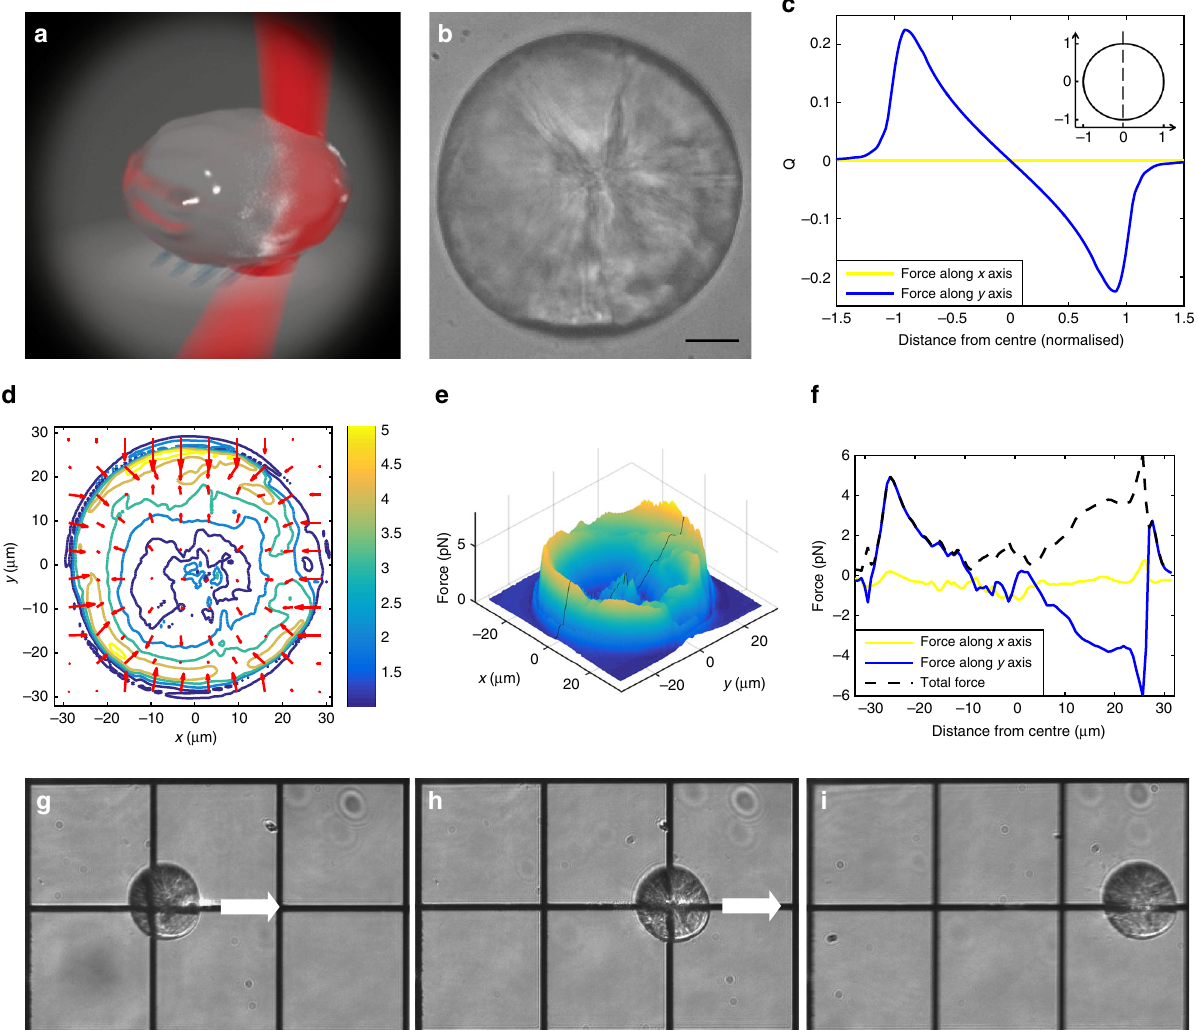
Fig. 1 Optical properties of otoliths for OT. a Illustration of a focussed beam de fl ected by an irregular ellipsoid. b A wide- fi eld image of a dissected otolith, showing internal irregularities ( Scale bar , 10 µ m). c Q factor ( blue curve ) for a scattered beam on a spherical particle calculated with ray optics approximations (see Supplementary Methods) along its y -axis ( dashed line , inset ). A positive ( upward ) force results from a trap at the bottom of the otolith ( inset ), and a negative ( downward ) force at the top. The effect is purely radial, with no predicted x -axis force ( yellow curve ). d Forces applied to a focussed laser by an otolith, measured with a PSD (see Supplementary Methods). Red arrows represent the direction and intensity ( arrow length ) of the forces at various positions. Contours show high intensity force regions in yellow and weaker intensity force regions in blue . e 3D representation of the total trap force across the otolith. The black line indicates the plane presented in the next panel. f The magnitude of the force in the x -direction ( yellow curve ) is weak across the y -axis. The blue curve shows the magnitude and direction of the force in the Y direction, and the dashed black line shows the magnitude of the total force applied by the otolith to the focussed beam. g – i Movements of a dissected utricular otolith under the in fl uence of a 250 mW OT at its right edge (Supplementary Movie 1). Grid spacing is 100 µ